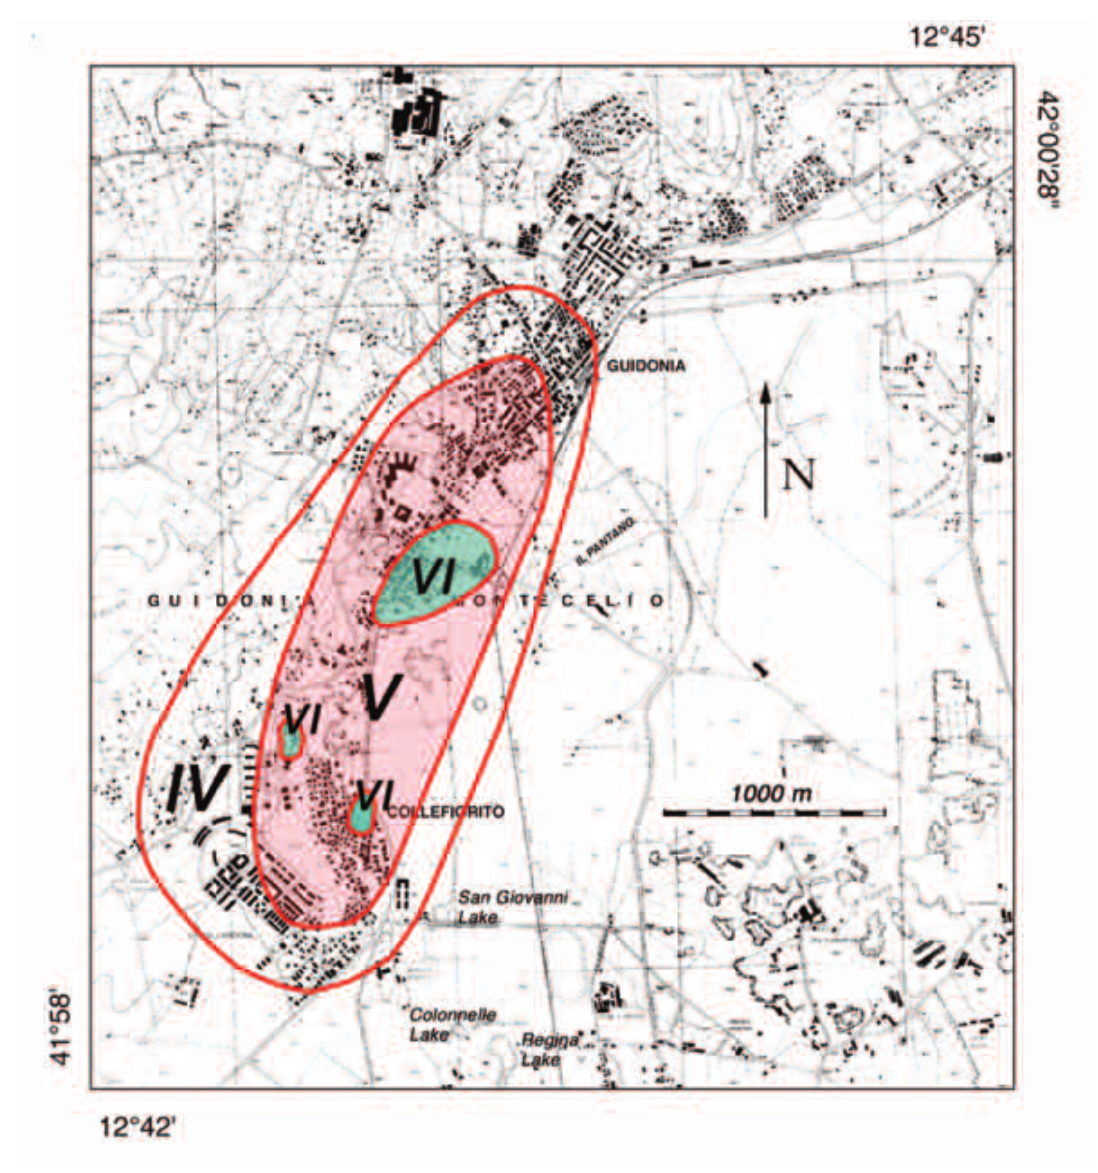
Fig. 5. Macroseismic investigation of the event which occurred on November 7, 2001 at 3:06 a.m.